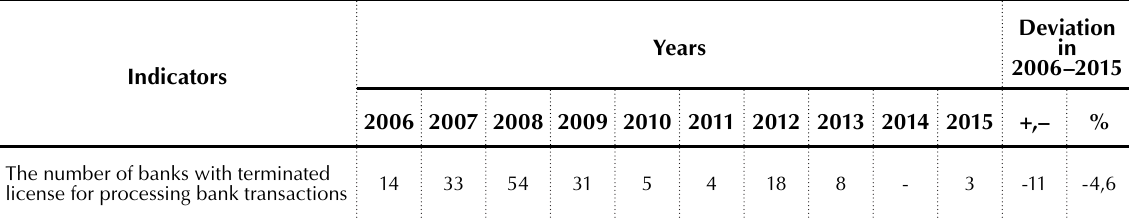
Table 3. Analysis of the state of the banking system in Kazakhstan